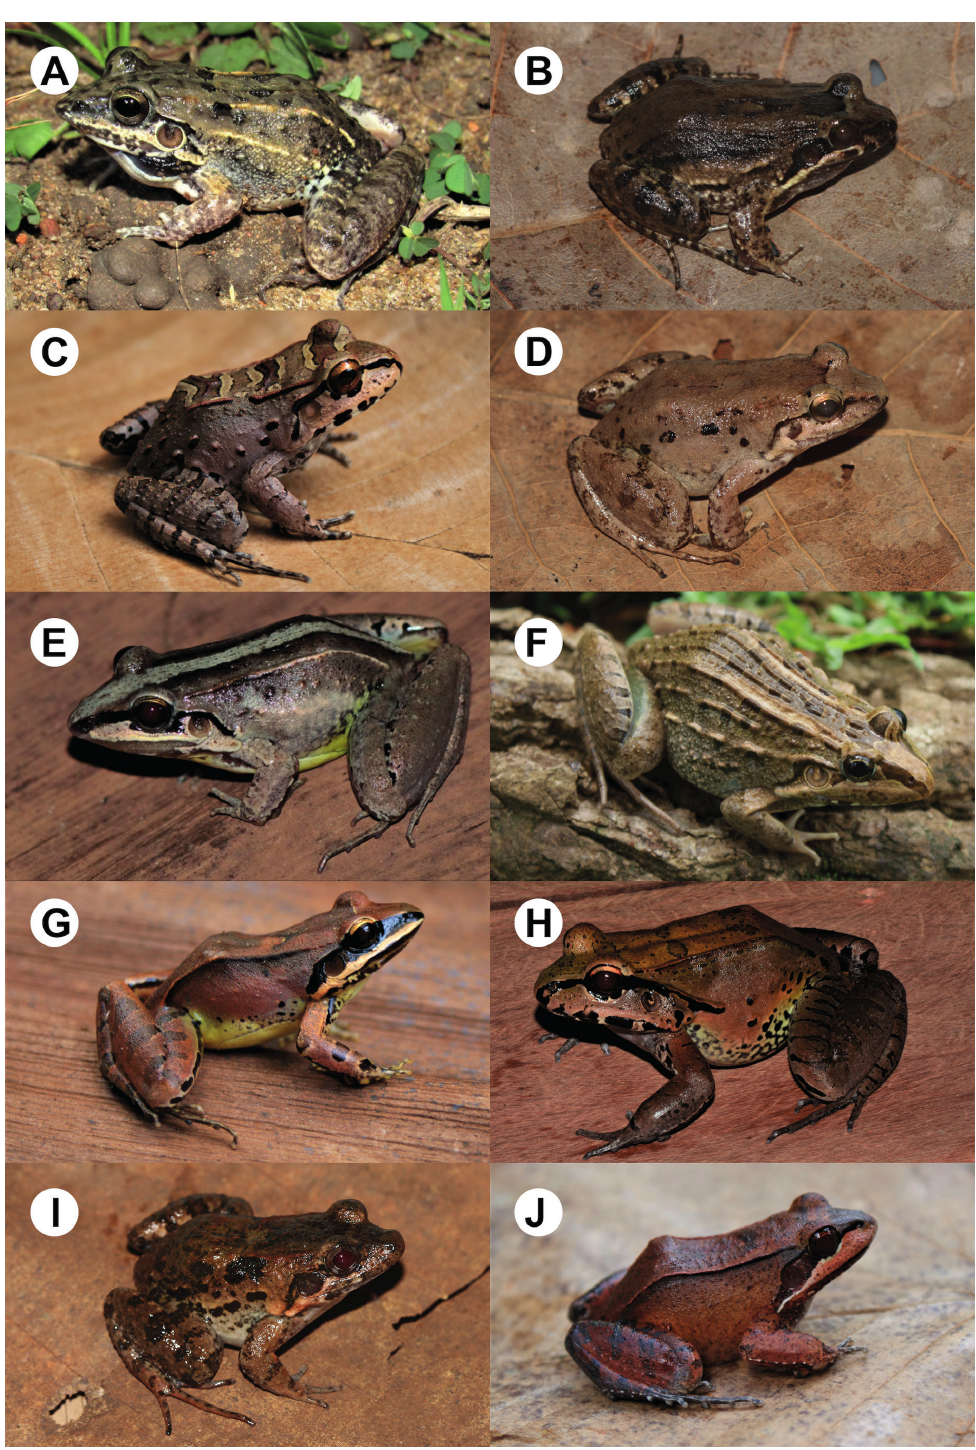
Fig. 5. Anuran species recorded in the state of Amapá. A . Leptodactylus fuscus (Schneider, 1799). B . Leptodactylus intermedius Lutz, 1930. C . Leptodactylus knudseni Heyer, 1972. D . Leptodactylus leptodactyloides (Andersson, 1945). E . Leptodactylus longirostris Boulenger, 1882. F . Leptodactylus macrosternum Miranda-Ribeiro, 1926. G . Leptodactylus mystaceus (Spix, 1824). H . Leptodactylus pentadactylus (Laurenti, 1768). I . Leptodactylus petersii (Steindachner, 1864). J . Leptodactylus rhodomystax Boulenger, 1884 . Photos: C.E. Costa-Campos (A, C, E–H, J) and T.R. Carvalho (B, D,